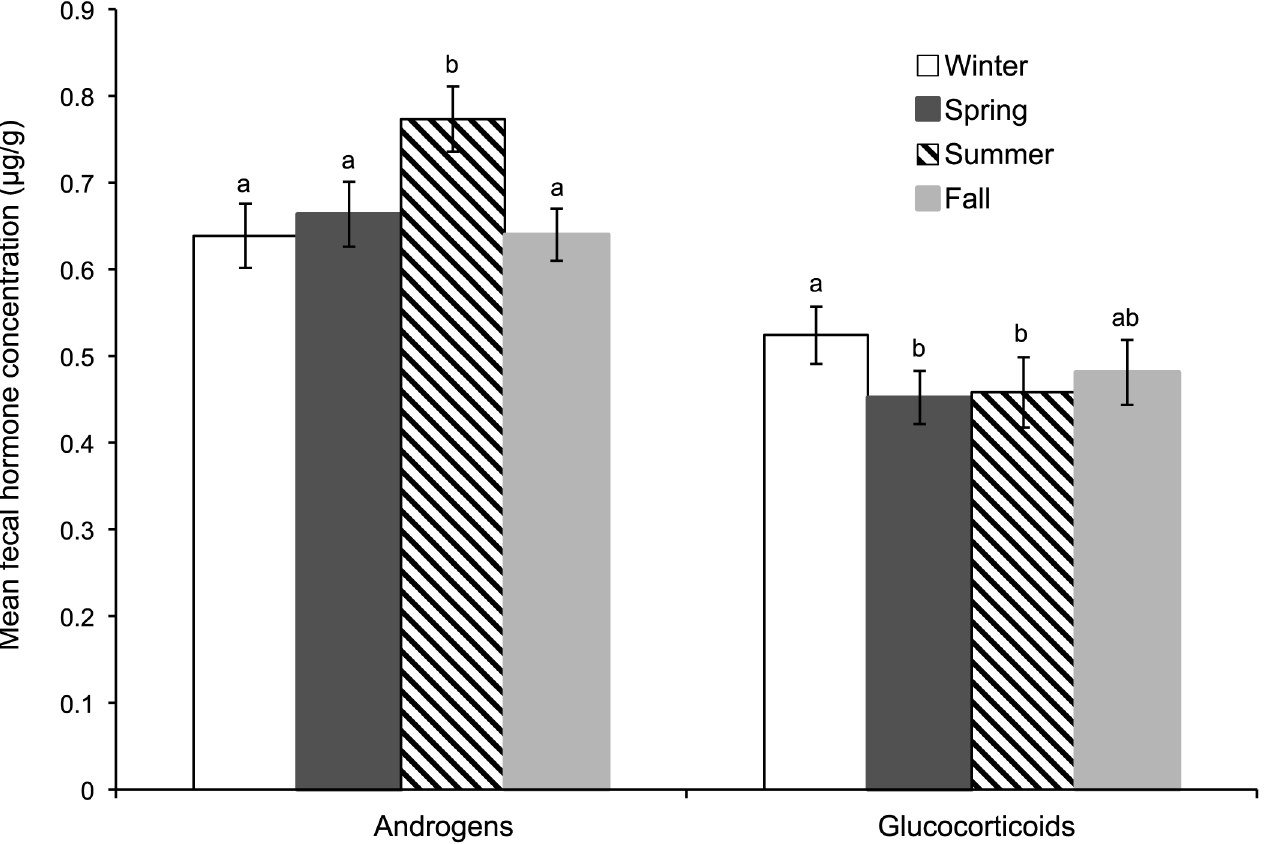
Fig 3. Mean ( ± SEM) fecal glucocorticoid and androgen metabolite concentrations in male cheetahs (n = 29) managed in North American zoological institutions across seasons. Within hormonal metabolite, different superscripts represent differences ( P < 0.05) in hormonal concentrations.